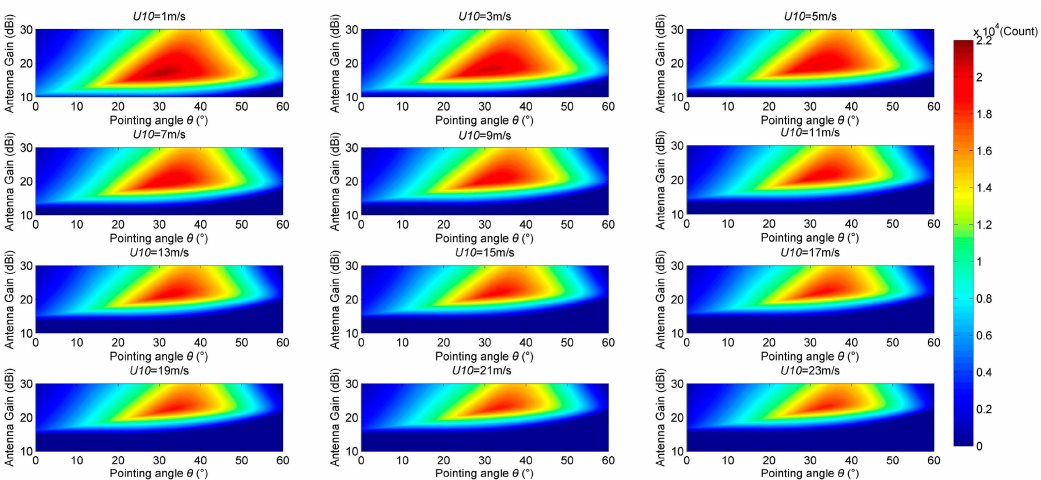
Figure 6. The relationship between the number of received reflection signals and antenna gain and pointing angle with respect to di ff erent wind speeds. The U 10 is the wind speed at 10 m height above the sea